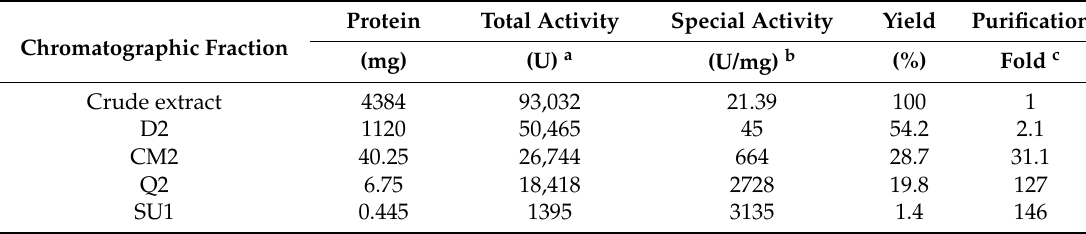
Table 1. Summary of purification of